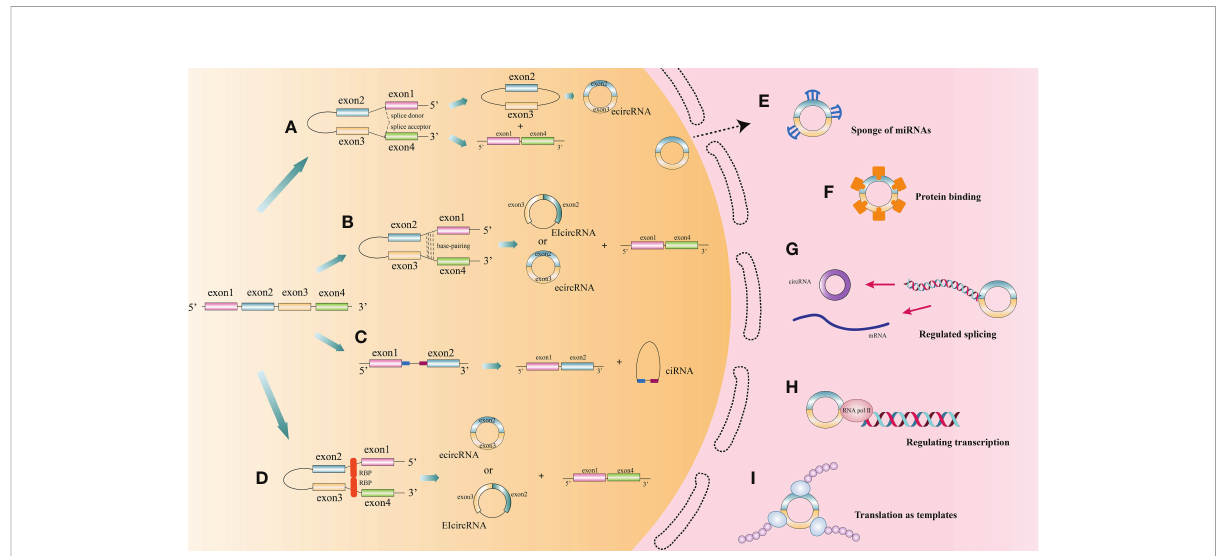
FIGURE 1 The biogenesis process and function of circRNA. (A) Lariat-driven circularization: During splicing of mRNA precursors, exon skipping produces a lariat intermediate containing both exons and introns. This intermediate will be reverse spliced and introns will be removed to form ecircRNAs. (B) Some introns on either side of one exon of a circRNA contain reverse complementary sequences. the RNA duplexes form two different types of circRNAs by variable splicing: circRNAs with introns and without introns, or introns within and on either side of one exon, which can compete for RNA pairing. (C) CiRNAs model. CiRNAs are generated by splicing reactions of introns. GU-rich elements near the 5 ’ -splice site and C-rich elements near the branching site stabilize CiRNAs to avoid splicing. (D) RNA-binding proteins (RBPs) drive the cyclization of circRNAs. RBPs facilitate the formation of circRNAs by bridging the two sides of introns together. (E) CircRNAs act as endogenous competitive RNAs or miRNA sponge in cytoplasm. (F) CircRNAs act as protein sponge or protein storage library. (G) CircRNAs regulate splicing. (H) CircRNAs regulate transcription. (I) Translation function of